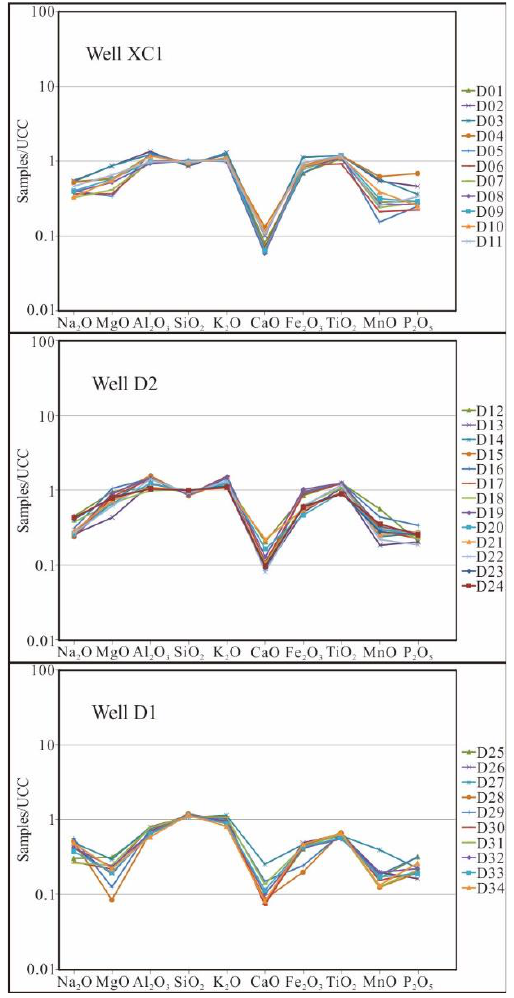
Figure 4. UCC − normalized major element spidergrams of the samples